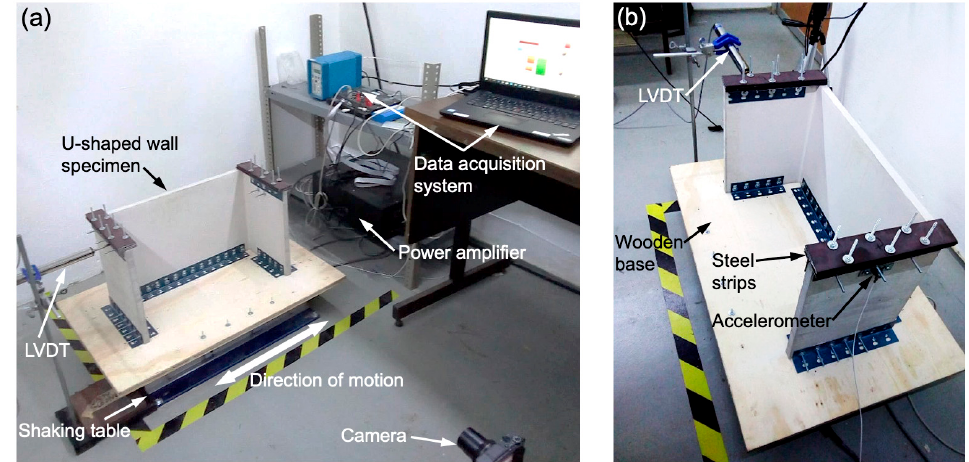
Figure 4. ( a ) Shaking table test set-up and ( b ) linear variable differential transformer (LVDT) and accelerometer positions.